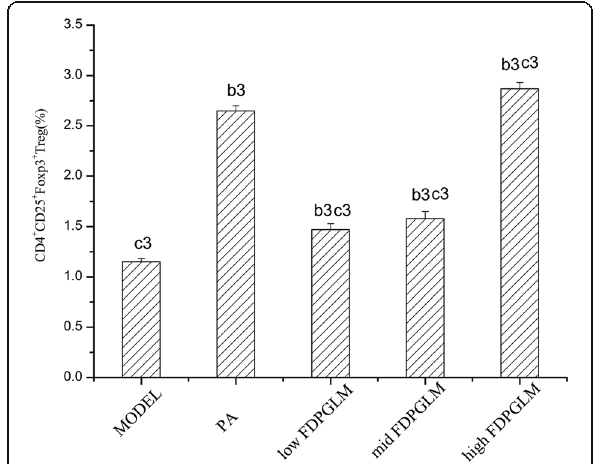
Fig. 4 Effect of FDPGLM on the differentiation of CD4 + CD25 + Foxp3 + Tregs in peripheral blood